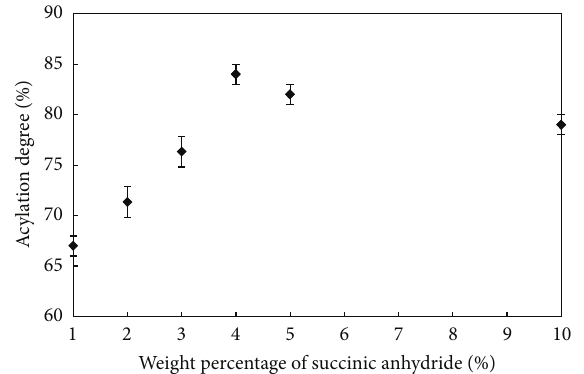
Figure 3: The influence of succinic anhydride weight percentage against Ap -SF on acylation degree.